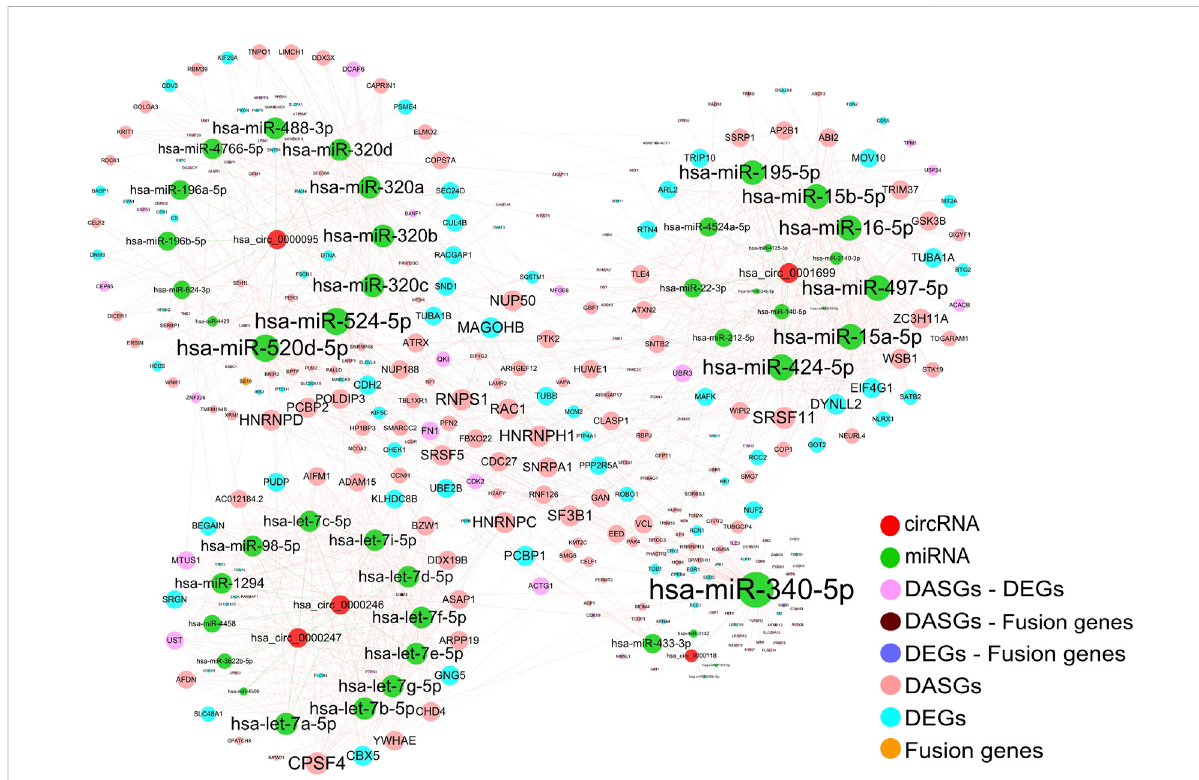
FIGURE 6 InteractionnetworkamongcircRNAs,miRNAs,andrelatedtargetgenes.Theedgesrepresentthepotentialinteractionsbetweendifferenttypes of genes and the size of each node is in proportion to the degree of edges. Only the target genes of DEGs, DASGs, fusion genes, and the parental genes of differentially expressed circRNAs were considered for corresponding miRNAs. The protein-protein interactions were obtained from the STRING database, while the known circRNA -miRNA interactions were downloaded from starBase. The resulting interaction network contains 5 circRNAs, 44 miRNAs, and 293 protein-coding genes. DEGs: differentially expressed genes; DASGs: differentially alternative spliced